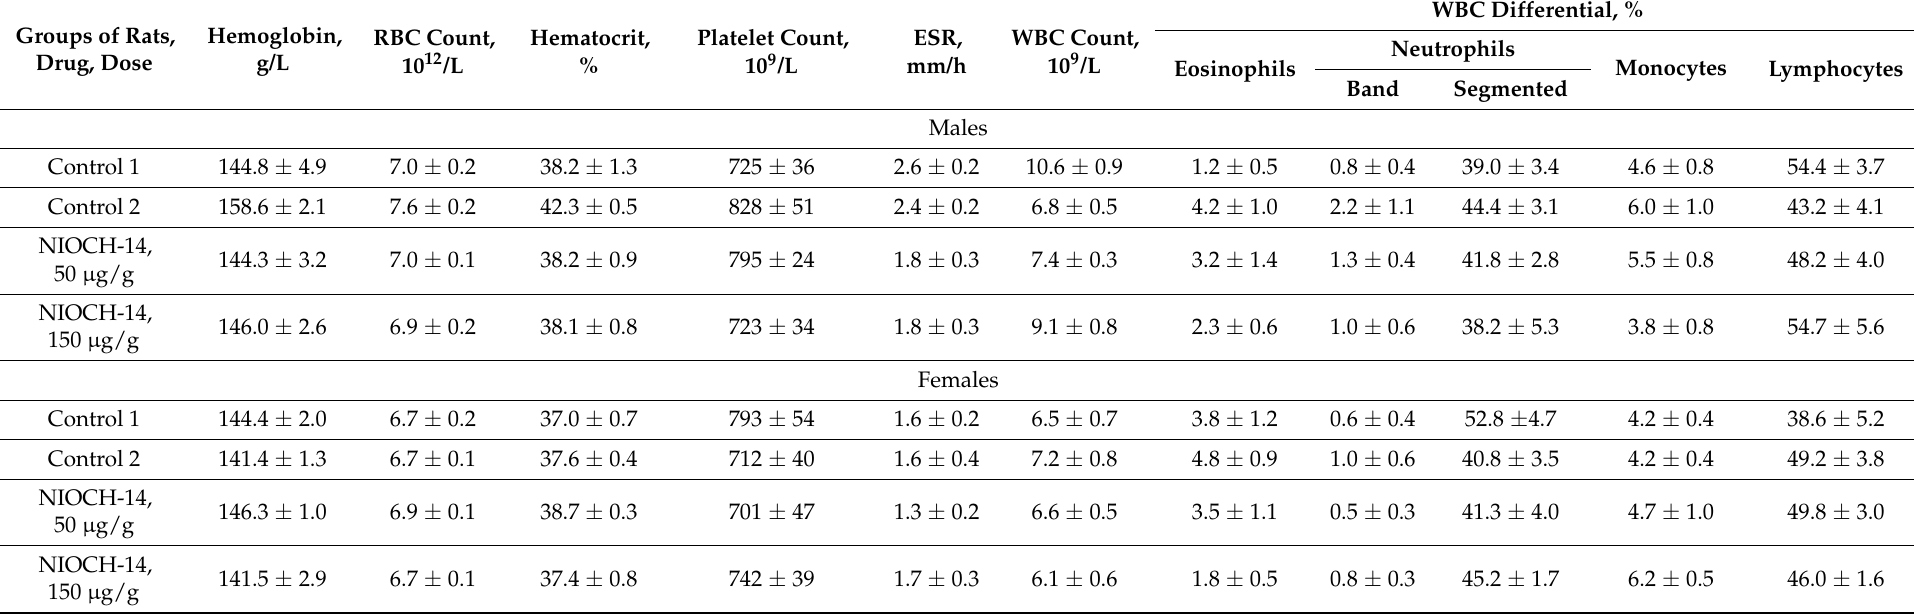
Table 3. Hematological parameters 1 day after the end of intragastric administration of NIOCH-14 to Wistar rats once daily during 30 days. Groups of